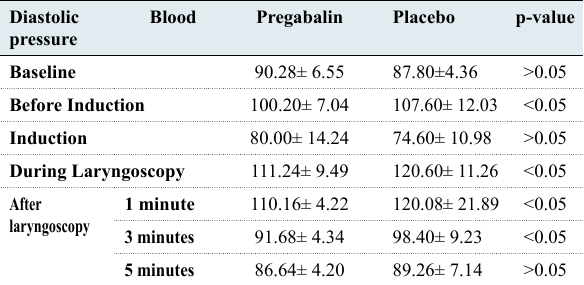
Table 5: Comparison of Mean Arterial